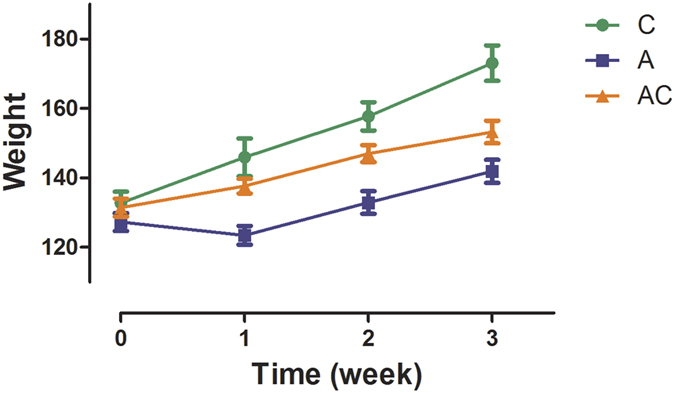
Increasing of the body weight in rats (C: control group, A: antibiotic group, AC: CSGS + antibiotic group).